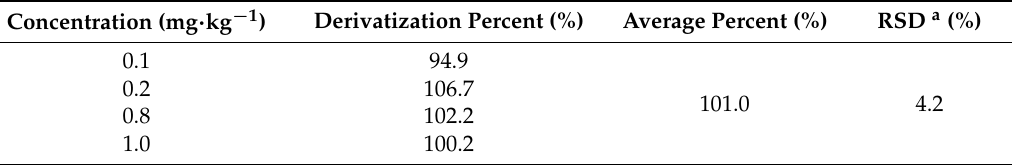
Table 1. Derivatization percent of prochloraz to